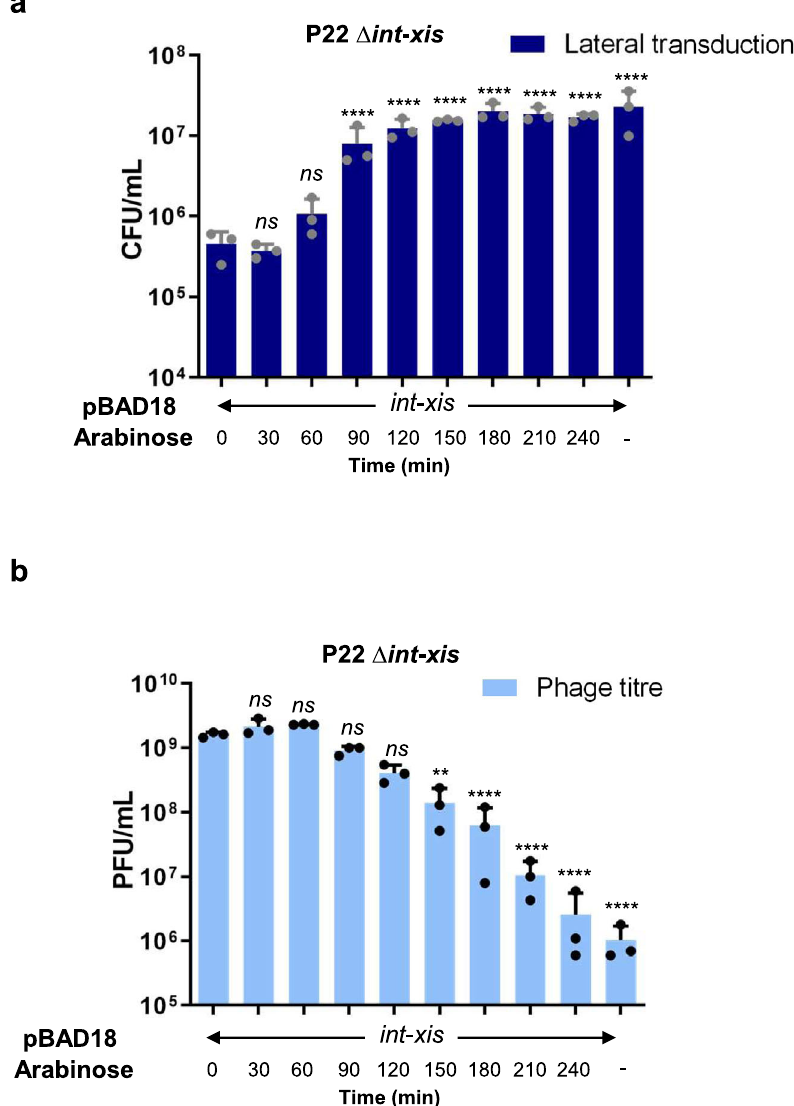
Fig. 5 Effect of early or delayed excision on lateral transduction and phage formation. The lysogenic strain for phage P22 mutant Δ int-xis , carrying a plasmid expressing the int and xis genes, was mitomycin C-induced to activate the prophage, and arabinose (0.02%) was added at different time points after induction of the resident prophage to facilitate int-xis expression in trans . ( − ): no arabinose added. Lysates were tested for transduction of the tetracycline ( tet A) marker (colony forming units per millilitre: CFU/mL) ( a ) and to determine the phage titers (plaque forming units per millilitre: PFU/mL) ( b ). Error bars indicate standard deviation from the mean of three independent experiments. For all panels, values are means ( n = 3 independent samples). A one-way ANOVA with Dunnett ’ s multiple comparisons test was performed to compare time 0 against the other timepoints. Adjusted p values were as follows: ns > 0.05; * p ≤ 0.05; ** p ≤ 0.01; *** p ≤ 0.001; **** p ≤ 0.0001. The exact statistical values for each of the conditions tested are listed in Table